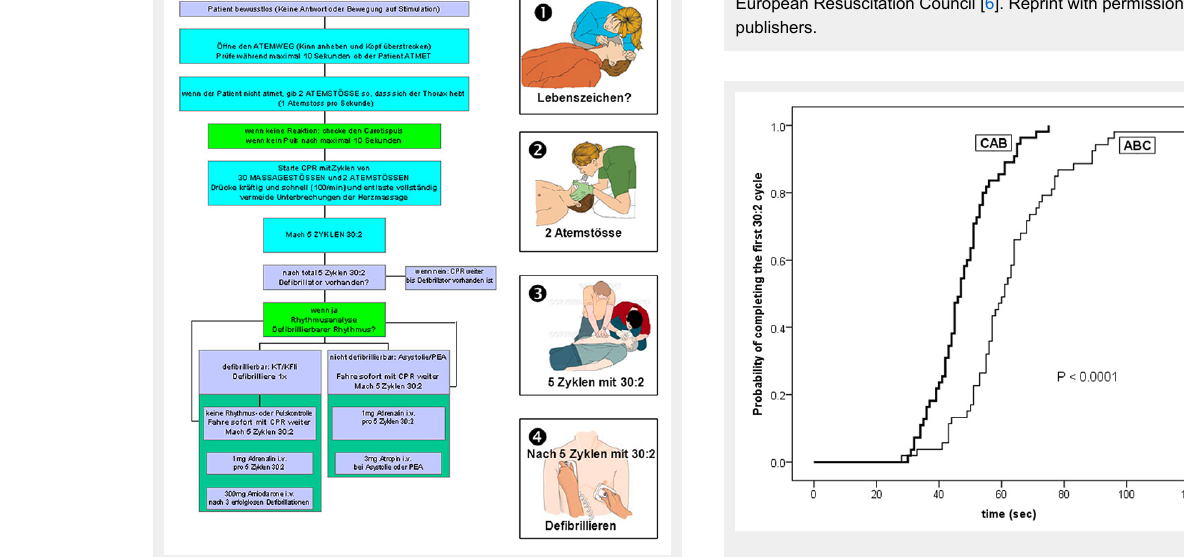
Instruction of the ABC algorithm corresponding to the 2005 guidelines of the American Heart Association [8]. The instruction includes illustrations from the electronic version of the 2005 guidelines of the American Heart Association [8] and the European Resuscitation Council [6]. Reprint with permission of the publishers.